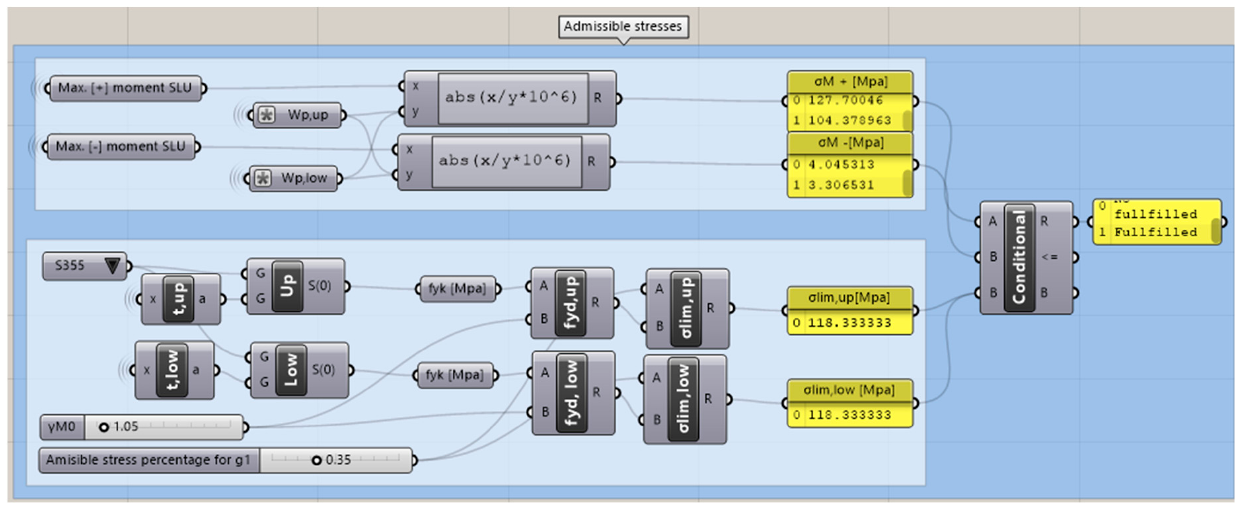
Figure 14. Visual algorithm development in Grasshopper canvas of the admissible stresses’ constraint.